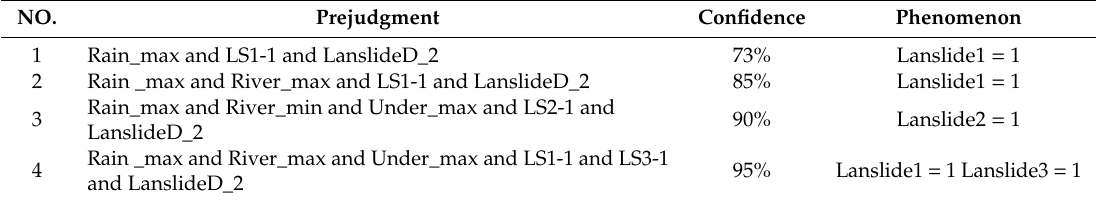
Table 3. Pre-judgment results by IAprioriMR.